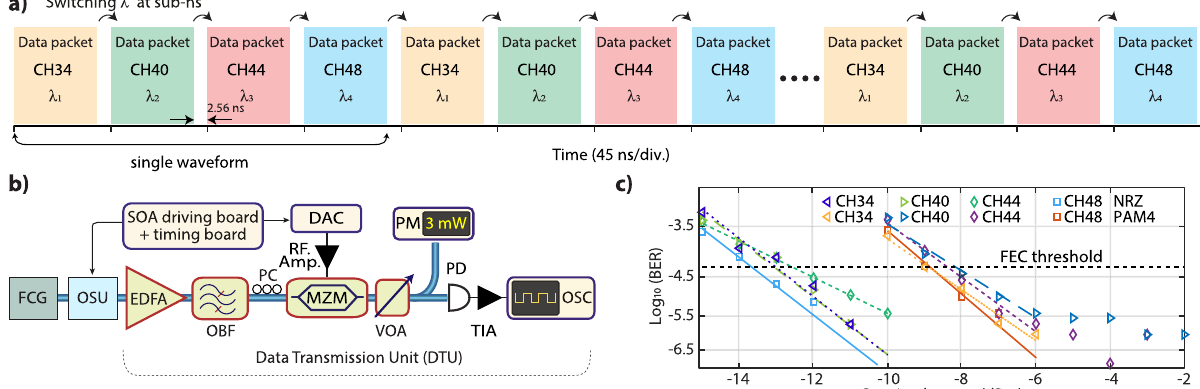
Fig. 3 Experimental demonstration of burst mode NRZ and PAM-4 transmission using discrete SOAs while switching. a A stream of multiple data packets showing data transmission along with sequential switching between the four comb channels. A single burst waveform sequence consists of header, payload, and guard zone containing 32, 1024, and 64 symbols respectively. b The signal after the frequency comb generator (FCG) and the optical switching unit (OSU) is ampli fi ed using a compact EDFA to compensate for losses of the 20-GHz Mach-Zehnder modulator (MZM). Then, it is fi ltered out using a wide-band optical bandpass fi lter (OBF) (~20 nm) to reject ampli fi ed spontaneous emission (ASE) noise from the SOAs and the EDFA. The data are encoded on the modulator using an arbitrary waveform generator (DAC). A fast photodiode (PD) is used to detect the signal. The electrical signal is ampli fi ed using a trans-impedance ampli fi er (TIA) and fi nally captured by an OSC. c ) The bit error ratio (BER) of four different comb channels while switching between them, using different modulation formats non-return to zero (NRZ) and four-level pulse amplitude modulation (PAM-4). A performance below forward error correction (FEC) threshold is achieved for NRZ and PAM-4 for a received optical power of ~ − 12 dBm and ~ − 8 dBm, respectively. CH- 34: 1552.524nm, CH-40: 1557.363 nm, CH-44: 1560.606nm, and CH-48: 1563.863 fl oor for PAM4 at a ROP of > − 6 dBm emerges due to ASE and (PIC) based wavelength selector PIC with a dimension of 6 mm × 8 mm. The re fl ection of the light from the high-re fl ection AWG crosstalk. (HR) coated facet allows simultaneous utilization of an AWG with 32 × 50 GHz separated channels as multiplexer and de- Photonic integrated circuit based optical switching and data multiplexer. This simpli fi es the wavelength alignment procedure transmission . Next, integrated Indium phosphide (InP) chip- and reduces the footprint of the device. Nineteen SOAs are based SOAs and AWG are used to show 25-Gbps NRZ burst connected via integrated waveguides to AWG output channels. mode data transmission along with fast OCS using a soliton The wavelength alignment of the comb channels to the AWG is microcomb. Figure 4b shows the photonic integrated circuit